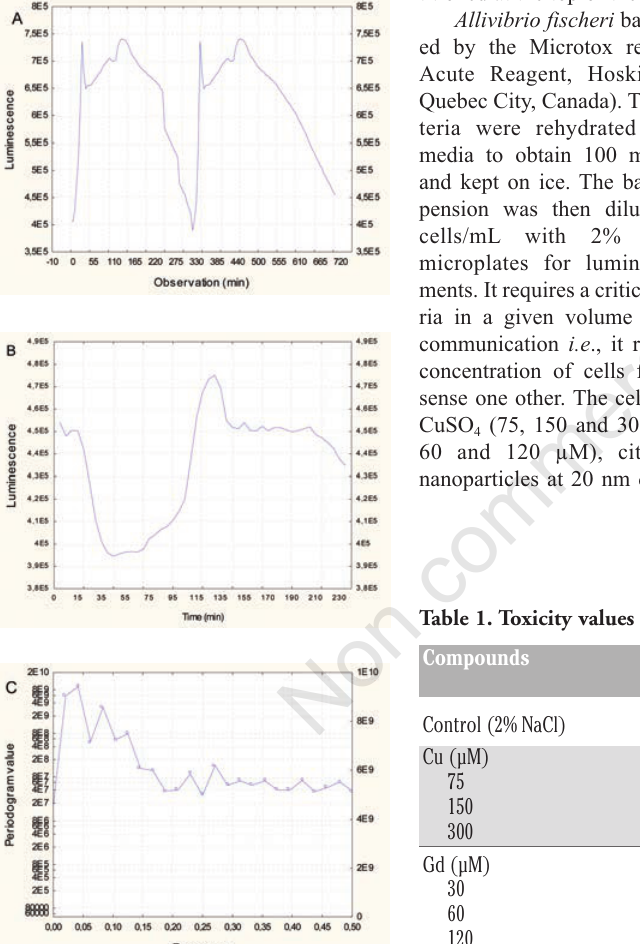
Figure 1. Change in luminescence in Allovibrio fisheri . Bacteria were re-sus- pended at 20 million cells/mL in 2% NaCl and luminescence was recorded at 5-min intervals for 3 h at 20°C under constant agitation. oscillatory changes at 20 million cells/mL (A), lumi- nescence for the first 50 observations (250 min) and frequency domain analysis (C) are